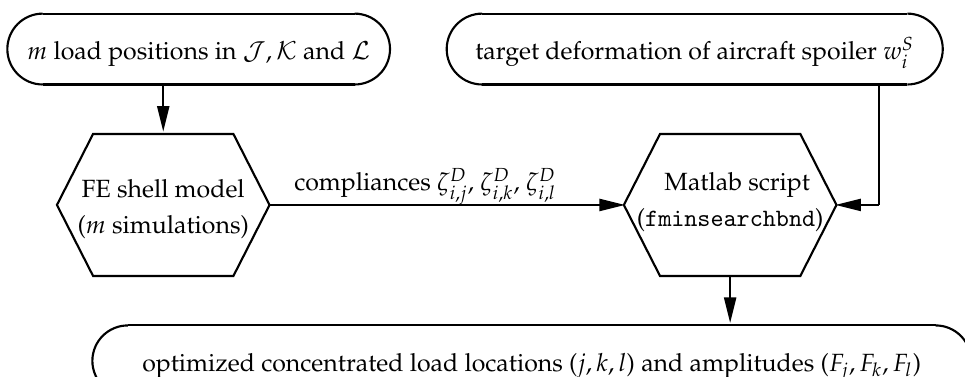
Figure 4. Flowchart of the proposed concentrated load optimization methodology.